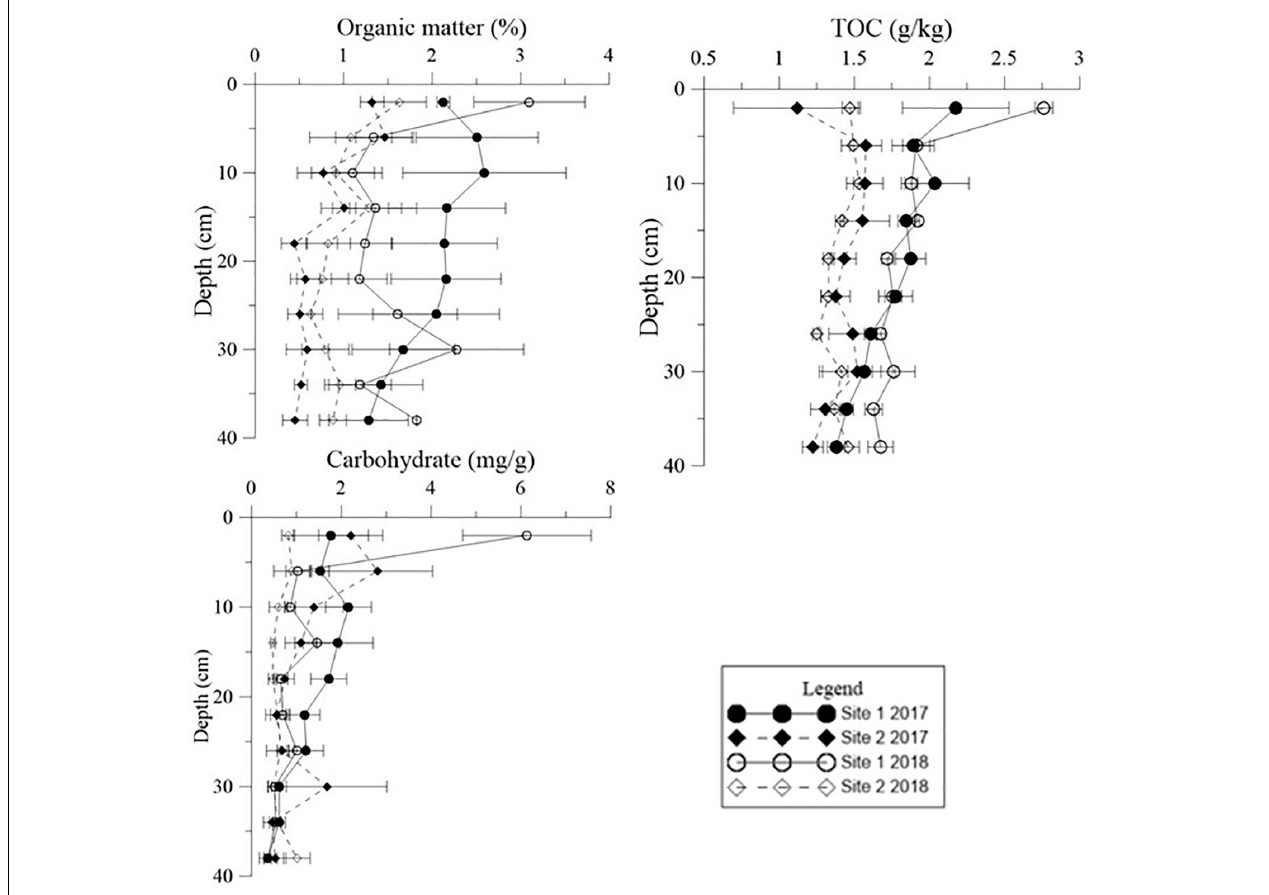
FIGURE 7 | Vertical distribution of organic matter (OM), carbohydrate levels, and total organic carbon (TOC) in the deep sediment cores from the two study sites in May 2017 and May